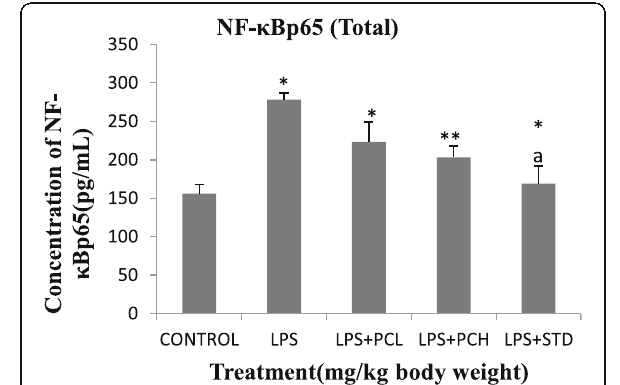
Fig. 3 Graphical Representation of levels of Nitric Oxide in Liver tissues of male Swiss albino mice. STD- Standard dose; PCL – Prosopis cineraria low dose; PCH- Prosopis cineraria high dose. Values are represented as mean ± SD (n = 6). *p < 0.05, **p < 0.001 v/s control group (C);ap < 0.05, bp < 0.001 v/s LPS treated